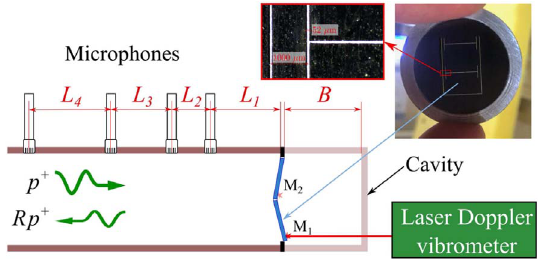
Figure 6. Schematic diagram of the setup for impedance tube experiments. Acoustic measurements are performed using four microphones separated by distances L 1 ... 4 ). Vibrations are evaluated using a Laser Doppler vibrometer, and two measure- ment points are de fi ned on the beam. The back cavity of length B can be removed to characterize the blade alone. The inset pictures display the composite sample used for the normal incidence measurements, as well as a zoom on the laser cut slits.